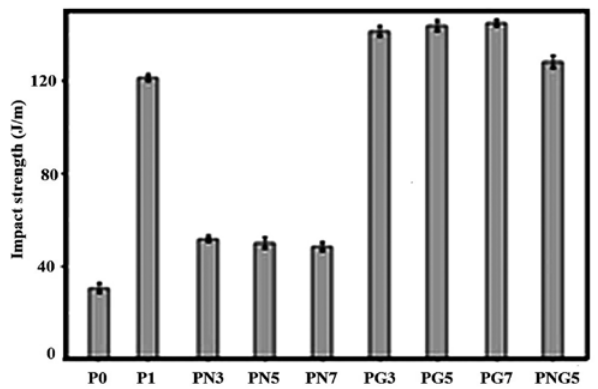
Figure 10: Impact strength of neat PA6 and PA6/PC/NBR blend with and without OC modifier and